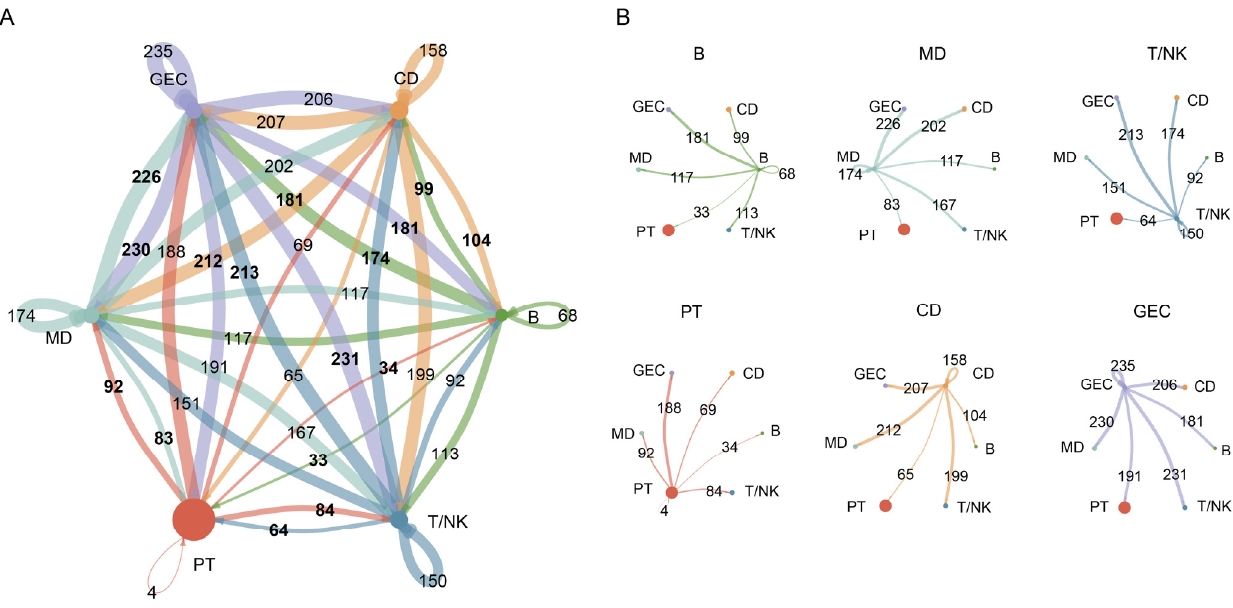
Figure 4. Cell–cell communication network in normal kidney immune microenvironment. ( A ) The number of interactions between any two cell types using a circle plot. The edge colors were consistent with the sources as senders, and edge weights were proportional to the interaction count. ( B ) Detailed view of the number of interactions sent from each cell type. Numbers indicated the quantity of ligand–receptor pairs for each intercellular link.